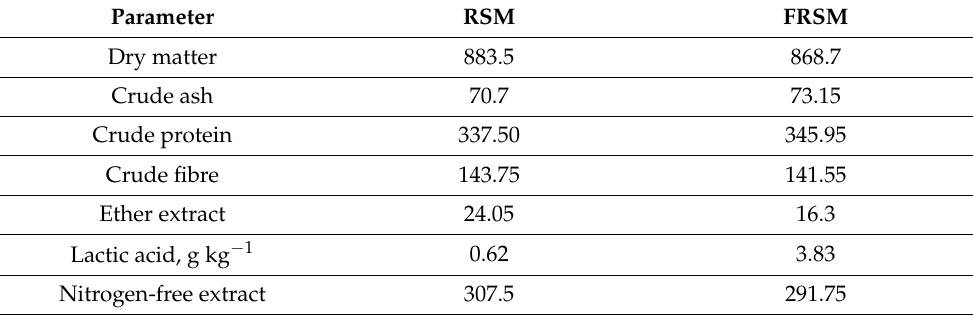
Table 1. The analysed nutritive value of raw or fermented rapeseed meals (g kg − 1 of